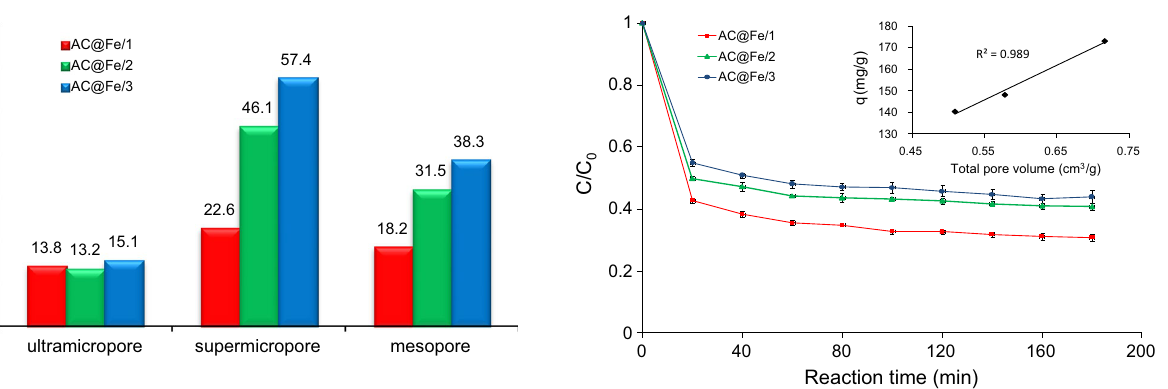
Fig. 6 Kinetics of Rhodamine B adsorption on AC@Fe/1, AC@Fe/2 and AC@Fe/3 catalysts (catalyst dose 0.2 g/L; pH 4.2; T = 28 °C; C 0 = 50 mg/L)